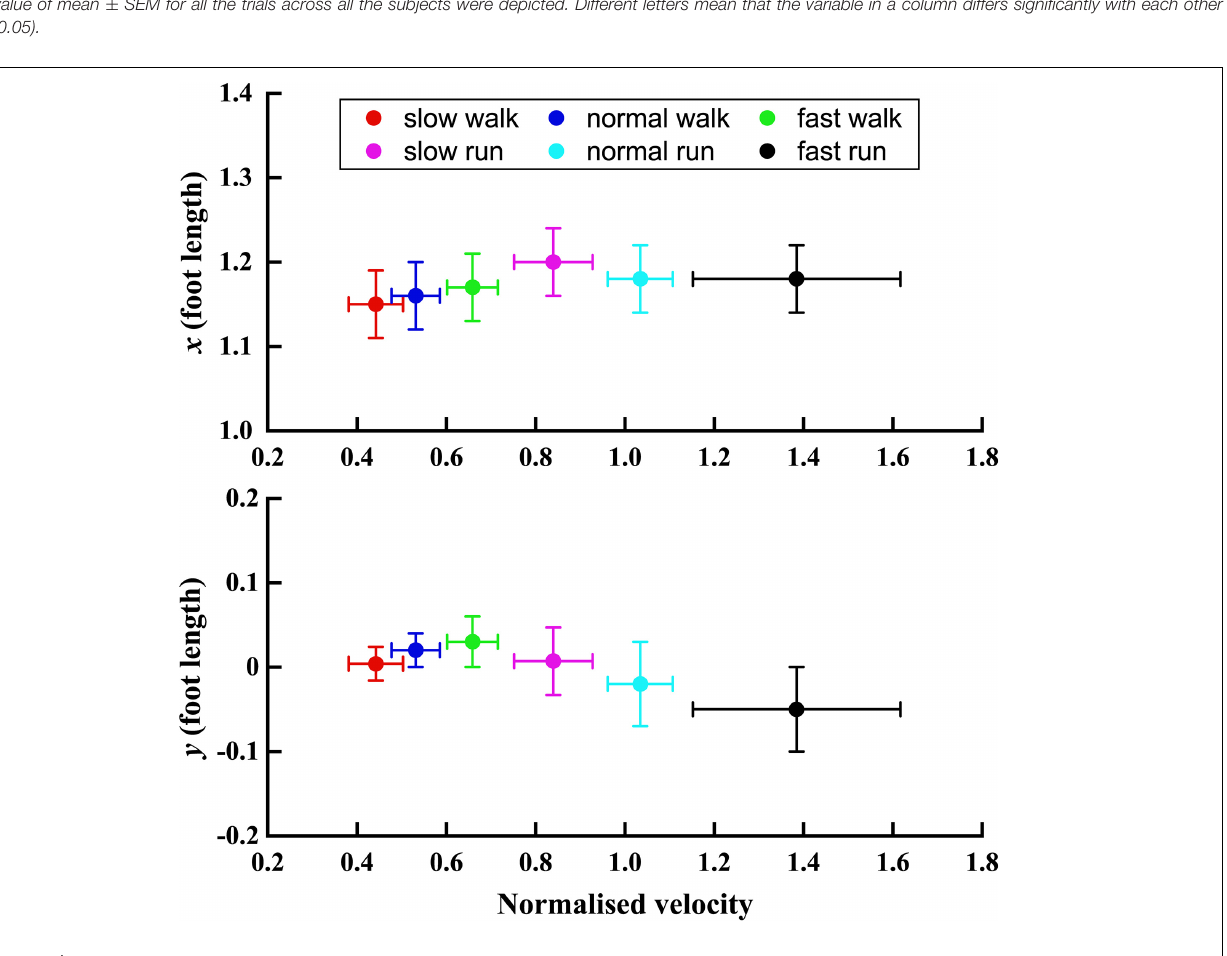
FIGURE 5 | The trend of x and y positions (normalised by the foot length) of the FA with the normalised velocity V increasing from slow walk to fast run. Circle plots depict mean; bars depict the 1 SD zones.